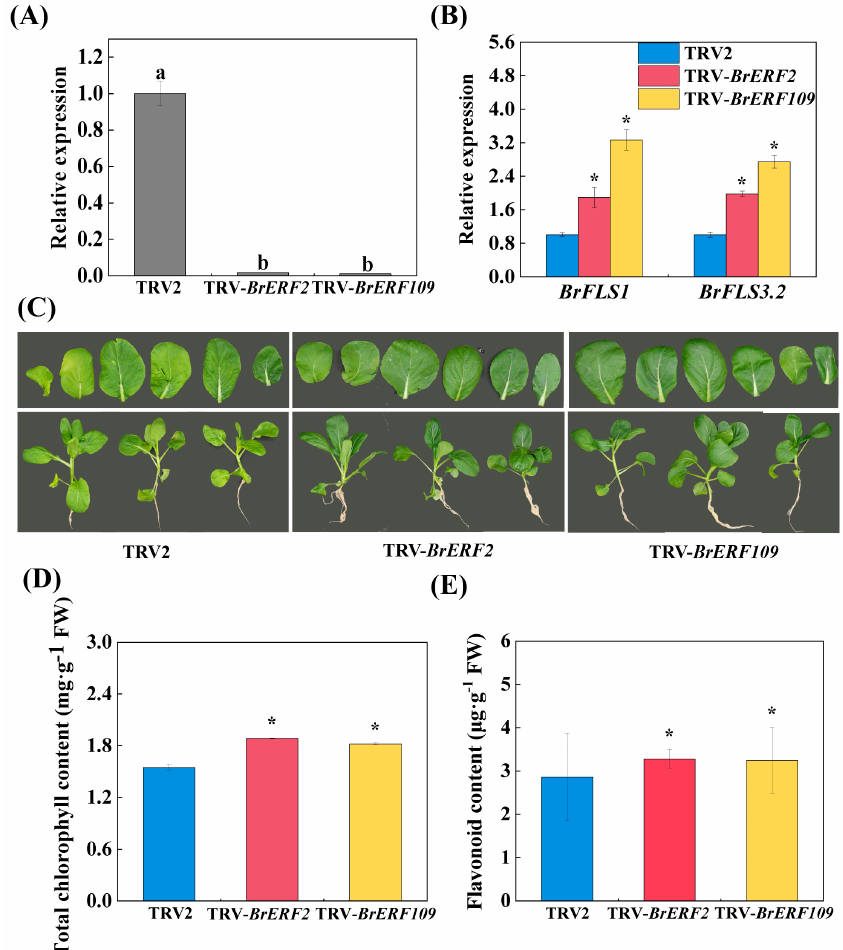
Figure 6. VIGS assay of BrERF2 and BrERF109 in flowering Chinese cabbage. ( A ), The transcription levels of BrERF2 and BrERF109 in TRV- BrERF2 and TRV- BrERF109 plants. ( B ), The expressions of BrFLS1 and BrFLS3.2 in TRV2, TRV-BrERF2 and TRV-BrERF109 plants. ( C ), The plant and leaves phenotypes of TRV2, TRV- BrERF2 and TRV- BrERF109 plants. ( D ), Total chlorophyll content of TRV2, TRV- BrERF2 and TRV- BrERF109 plants. (E), Flavonoid content of TRV2, TRV- BrERF2 and TRV- BrERF109 plants. Each value indicates the mean ± SD of three biological replicates. The asterisks above columns indicate a significant difference at * p < 0.05.